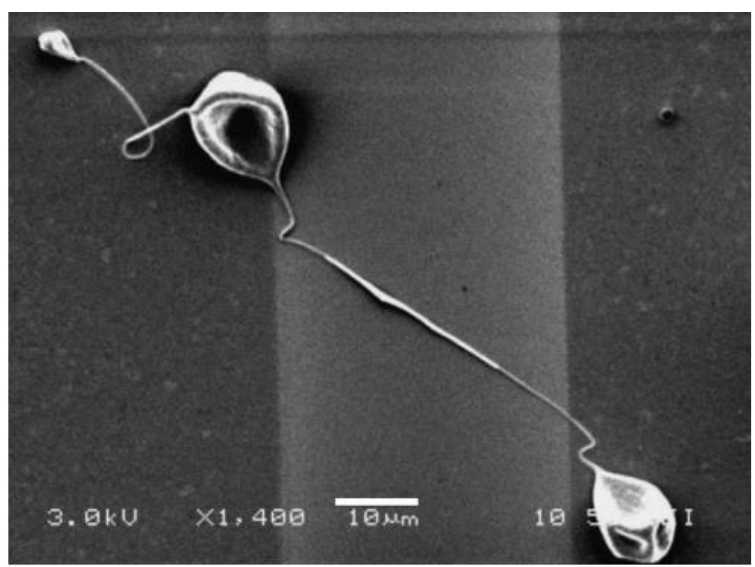
Figure 11. SEM showing a neat electrospun P3HT nanofiber having an average length of 54 µm and diameter of 670 nm [176]. Reprinted with permission from Ref. [176]. Copyright 2005 with permission from Elsevier.